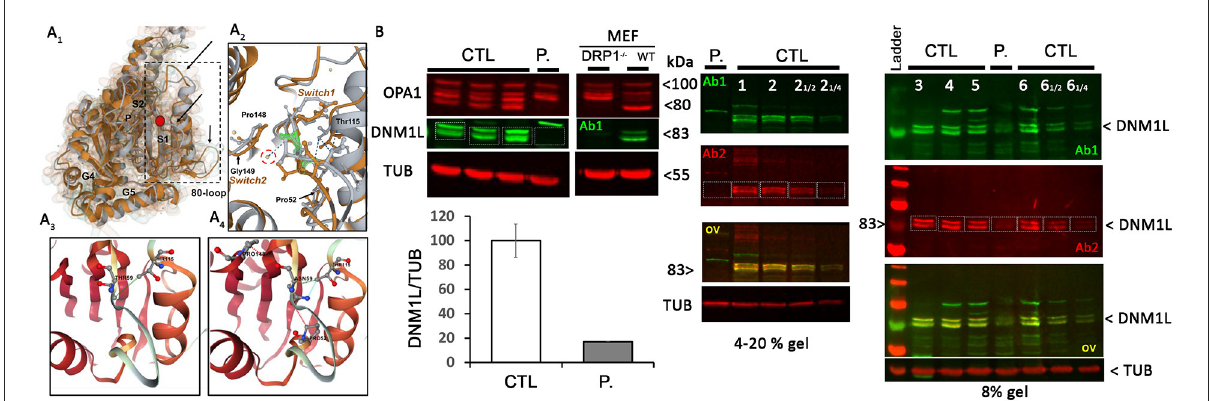
FIGURE1 DNM1L/DRP1 immunostaining shows the loss of DNM1L normal forms in patient fibroblasts. (A 1 ) Comparison of the GTPase domain structure of nucleotide-free, wild-type (orange, pdb code 4H1U) and mutated THR59ASN DNM1L (gray) in ribbon and Gaussian volume representation, using RCSB pairwise structure alignment tool. The mutation site is indicated by a red circle. Modeling indicates a disorganization of the switch 1 in which the mutation is located, but also in the unique 80-loop, α E1 G helix and the loop connecting α E1 G and the β 2A sheet (indicated by black arrow). (A 2 ) Close-up view of the switch1 in the nucleotide-free structure of the WT (orange) and mutated (gray) DNM1L. ASN59 is underlined in green. Water molecules are represented in yellow. The catalytic water molecule connecting switch I (THR59) with switch II (GLY149) by hydrogen bonds is circled in red. This interaction is lost with the amino acid switch THR59ASN. Amino acids interacting with THR59 or ASN59 are indicated. Detailed view of amino acid interactions in nucleotide-free wild-type (A 3 ) and mutated (A 4 ) protein structures. Hydrophobic interaction is in green, hydrogen bonds in red, and VDW in blue. Analysis was performed using Dynamut2. (B) OPA1 and DNM1L/DRP1 protein quantification and α -tubulin (TUB) as loading control in control (CTL) and patient (P.) fibroblasts. Control and DRP1 knock out MEFs: Mouse embryonic Fibroblasts models. On the right, overlay yellow staining of 2 DNM1L/DRP1 antibodies Ab1 and 2 indicates specific staining. ≪ ½ ≫ and ≪ ¼ ≫ : controls were charged at 1/2 and ¼ to control the linearity range of DNM1L signal detection.